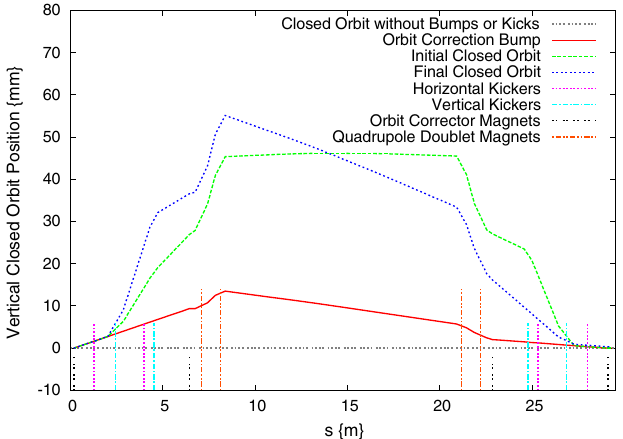
FIG. 10. Vertical closed orbit offsets in the injection straight section: (Red) orbit bump due to orbit correction dipoles, (green) initial closed orbit, and (blue) final closed orbit in the x - y 0 painting scheme. Also shown are the locations of the injection kickers, the orbit corrector magnets, and the quadrupole doublets. The stripper foil is located at the crossing point of the initial and final closed